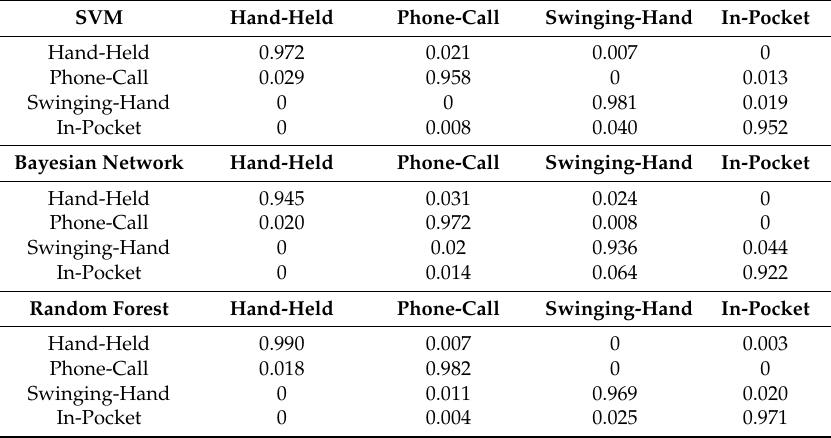
Table 1. Carrying position classifiers confusion